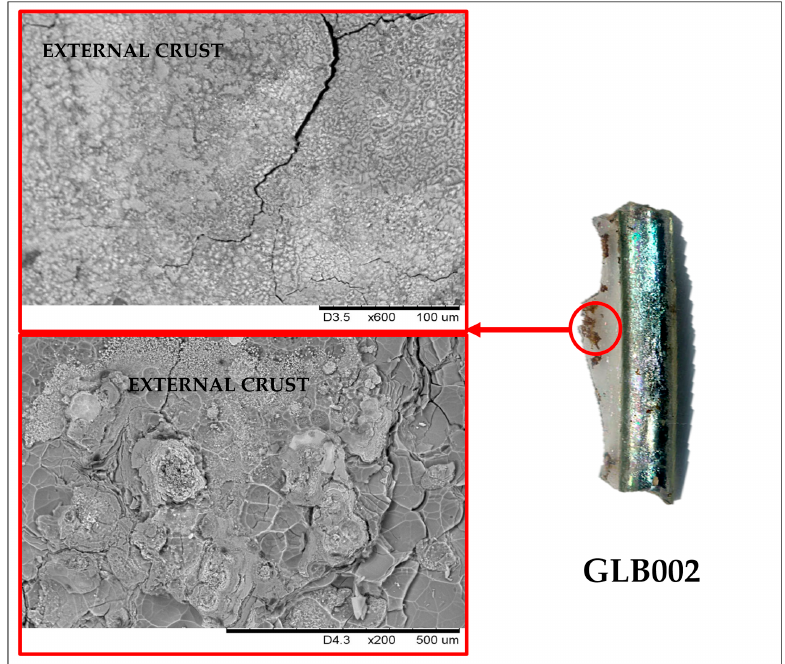
Figure 4. SEM images acquired on the dark-brown area of sample GLB002 .